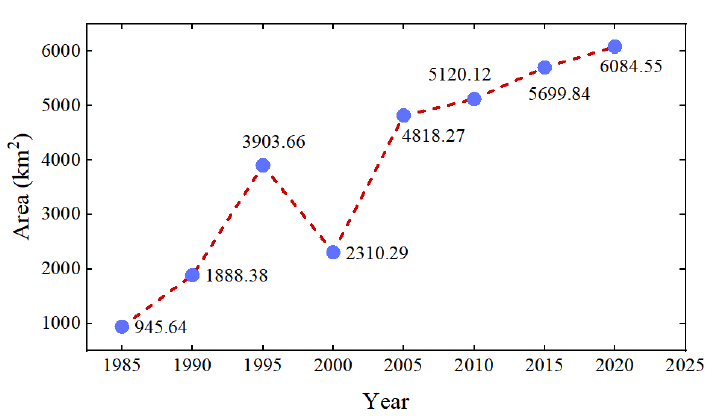
Figure 18. The coniferous forest area in the years 1985, 1990, 1995, 2000, 2005, 2010, 2015 and 2020. By 2005, the area of coniferous forests had rebounded significantly. From 2000 to Table 5. The area’s change information concerning coniferous forests from 1985 to 2020. 2005, the area of coniferous forests increased by as much as 2507.98 km 2 , and reached 4818.27 km 2 . From 2005 to 2020, the area of coniferous forests increased steadily, among Increased Reduced which the area of the coniferous forest increased by 301.91 km 2 , 579.69 km 2 and 384.60 km 2 Years Area ( km 2 ) ( km 2 ) rate of coniferous forests in the seven time periods (i.e., 1985–1990, 1990–1995, ( km 2 )